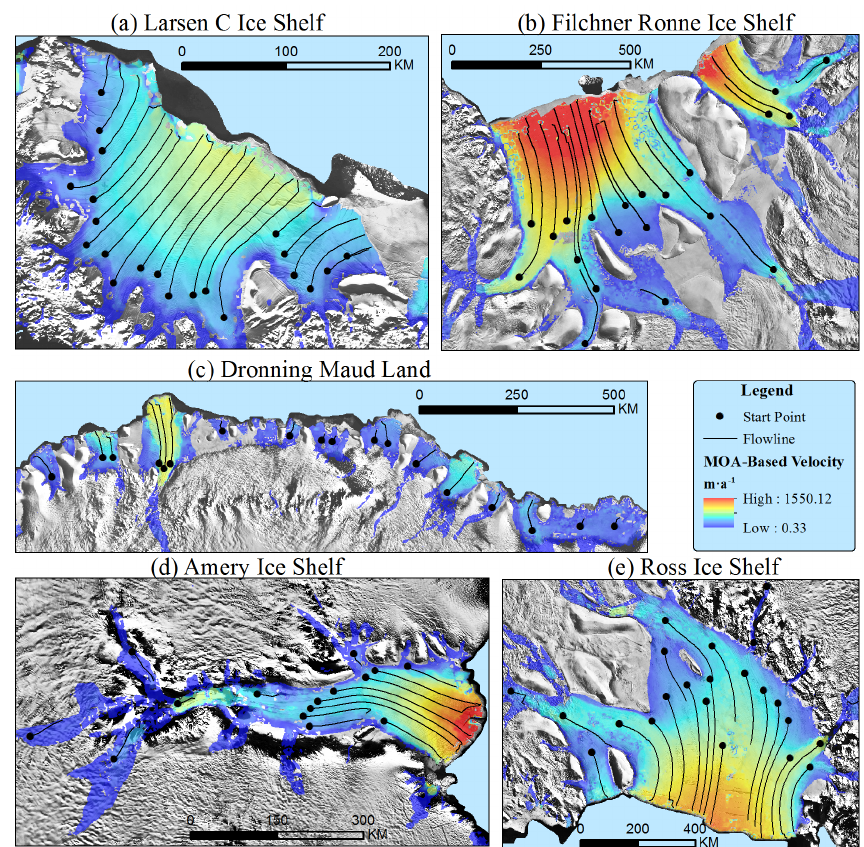
Figure 3. Start points and corresponding streamlines in ( a ) the Larsen-C Ice Shelf, ( b ) the Filchner-Ronne Ice Shelf, ( c ) the Donning Maud Land, ( d ) the Amery Ice Shelf, and ( e ) the Ross Ice Shelf, with transparent MOA tacking velocity field overlapping on the enhanced MOA 2009 image as the